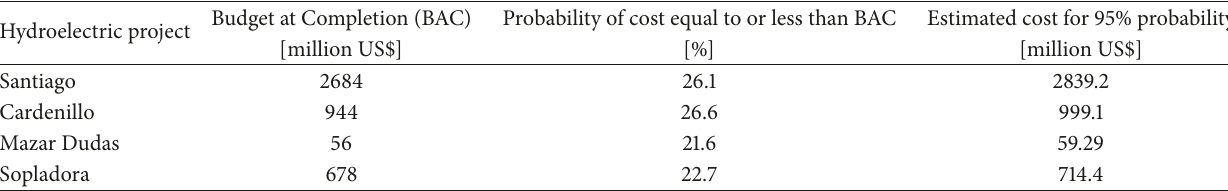
Table 4: Results of simulation models in regard to total costs.